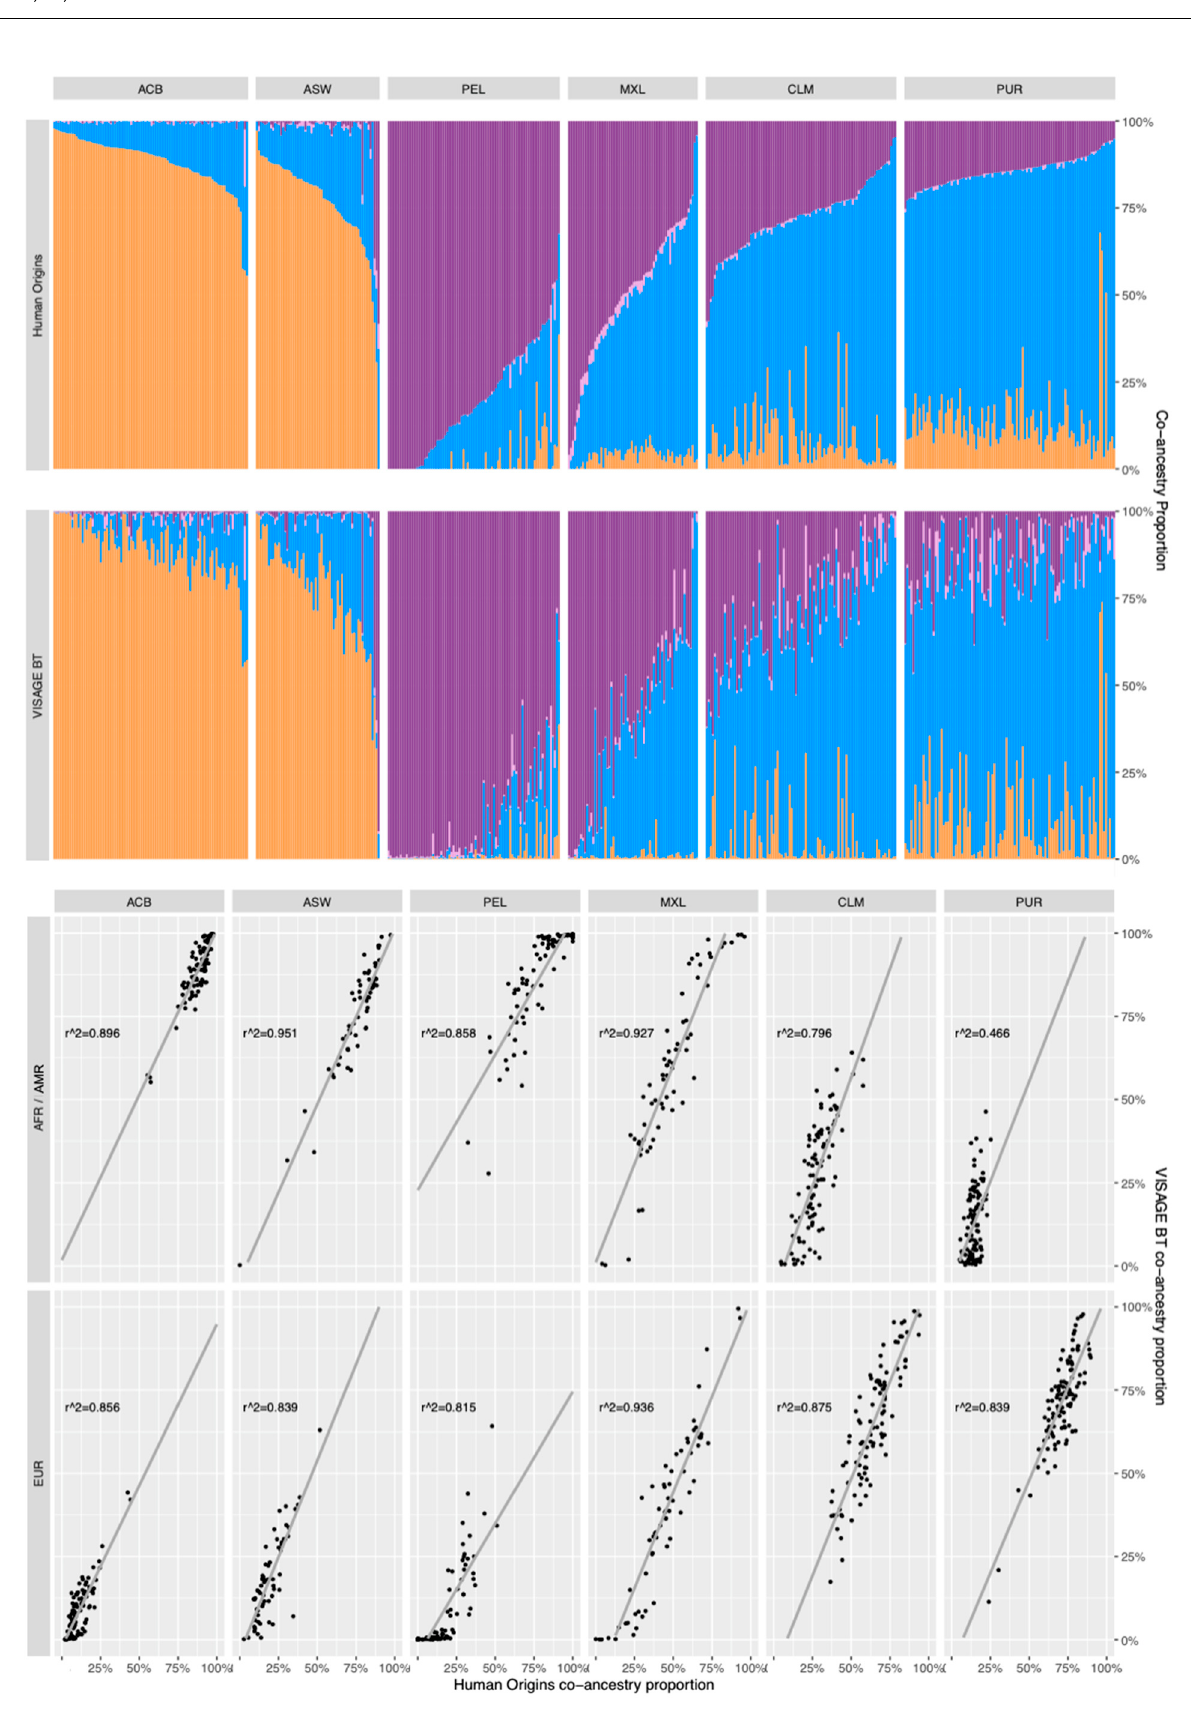
Figure 4. Pairwise comparison of individual co-ancestry proportions (cluster membership proportions) in 504 admixed samples from 1000 Genomes, analysed using the standardised reference set with Human Origins array, comprising